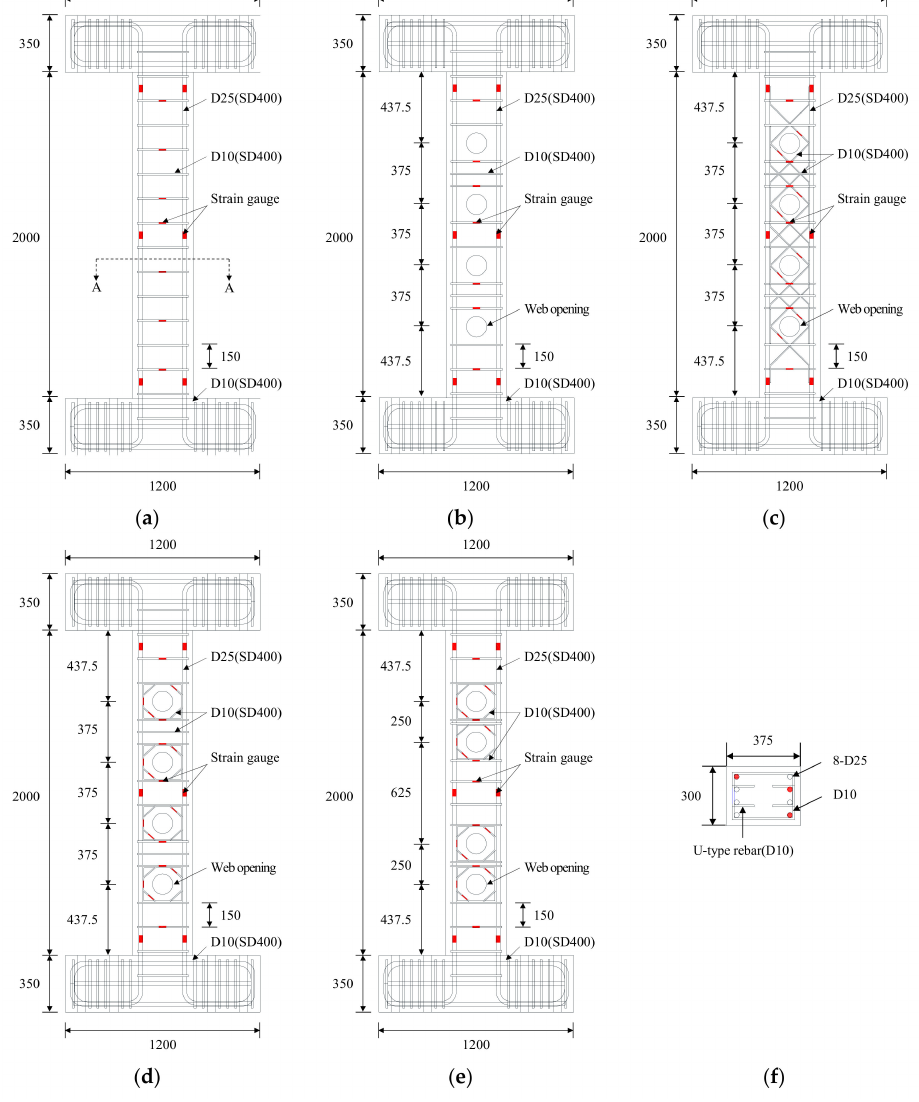
Figure 2. Details of specimens (unit: mm): ( a ) No. 1; ( b ) No. 2; ( c ) No. 3; ( d ) No. 4; ( e ) No. 5; ( f ) Section